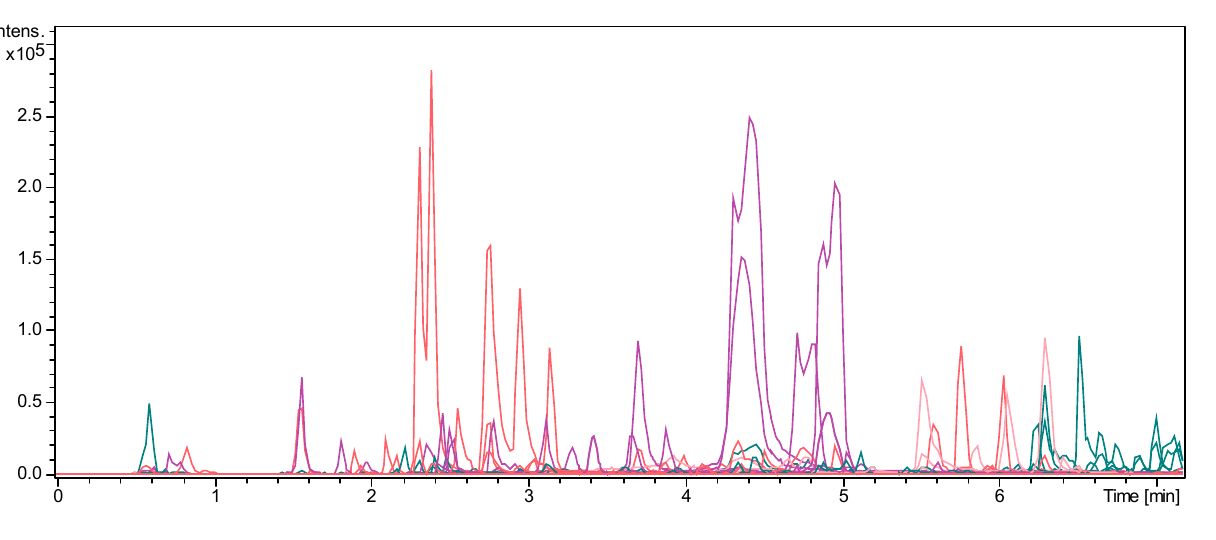
Figure 4. Extract ion chromatograms in negative electrospray ionization of corn silk extract from the characterized molecules. In purple, the compounds consistent with the literature of corn; in red, the characterized molecules in this study; in pink, the molecules with a start of characterization; and in green, the molecules with molecular family information.